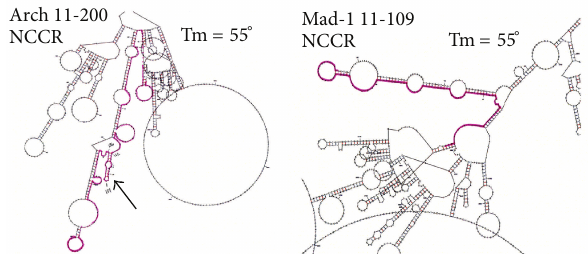
Figure 2: Potential stability of palindromes folded as hairpins in the NCCR region of JCV archetype and Mad-1 strains. Folding [72] was modeled at 55 ∘ C using JCV circular, single strands in 0.14M NaCl and 3 mM MgCl 2 . NCCR regions are highlighted in pink. The arrow denotes the palindrome typed in blue and boxed in Figure 1(b). Note that sequence rearrangements in Mad-1 remove internal hairpins present in the